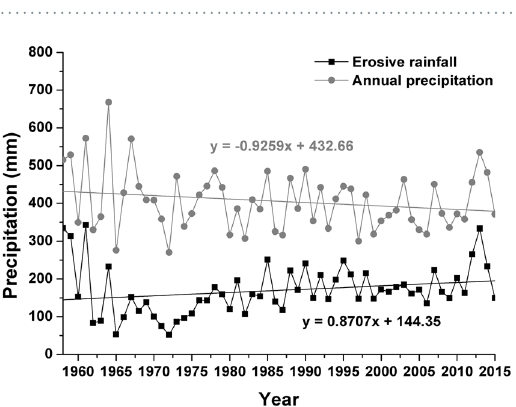
Figure 5. Trend of annual precipitation and erosive precipitation in the study